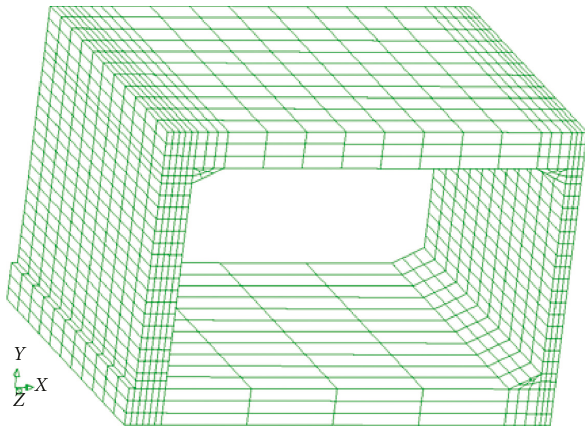
Figure 5: 3D finite element model of ¼ tunnel